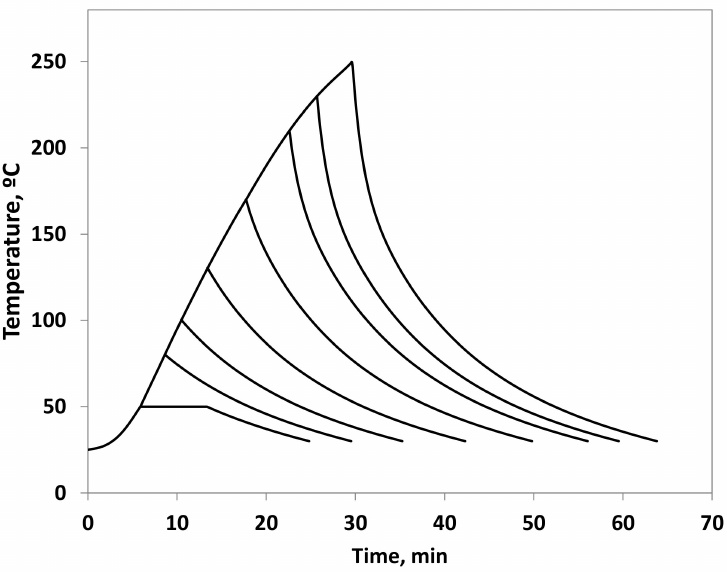
Figure 1. Temperature profile of each